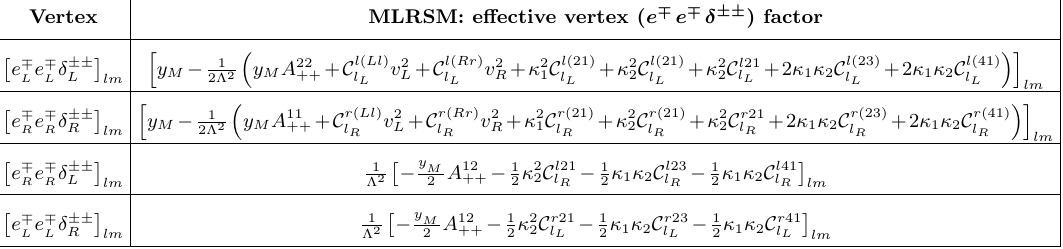
Table 37. MLRSM: coupling between the doubly charged scalar ( (cid:14) (cid:6)(cid:6) ) and a pair of same signed charged lepton ( e (cid:6) ). Here, the subscript L; R in the charged lepton ( e ) correspond to the SU(2) L;R .